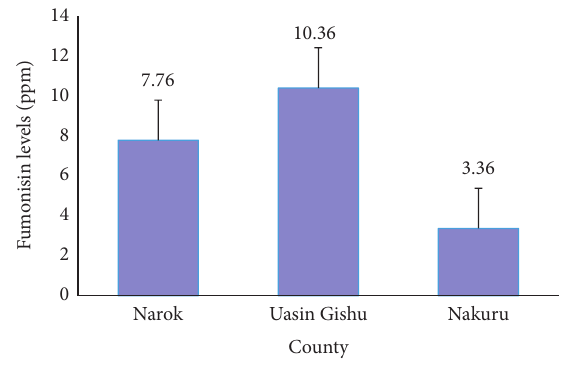
Figure 4: A comparison of fumonisin levels in the wheat grains sampled at harvest in three major wheat-producing Counties in Kenya.